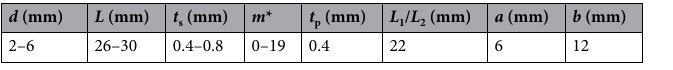
Table 2. The geometrical